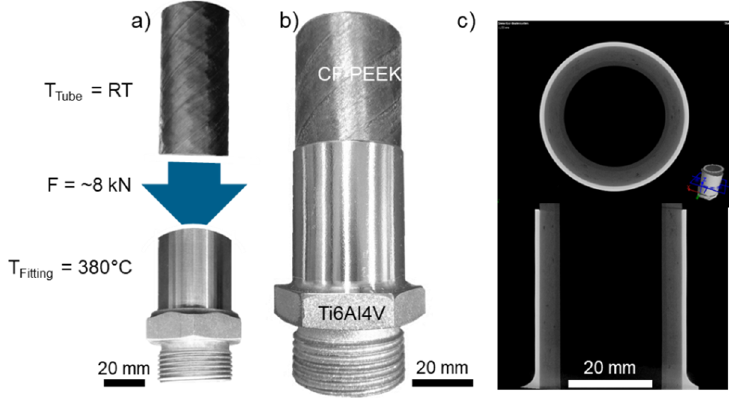
Figure 6. Preparation of the welding samples: ( a ) interference fit of the Ti6Al4V-fitting and the CF- PEEK-tube, ( b ) prepared Ti6Al4V-Fitting/CF-PEEK-tube for the welding process and ( c ) computed tomography (CT)-scan of the interference fit to screen gaps between the joining partner prior welding.